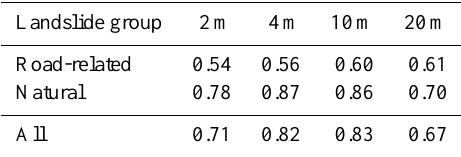
Table 5. Efficiency index for different DTM resolutions and for road-related landslides, natural landslides and for all landslides. Ef- ficiency index equal to 1 represents perfect model performances, and 0.5 represents naïve model